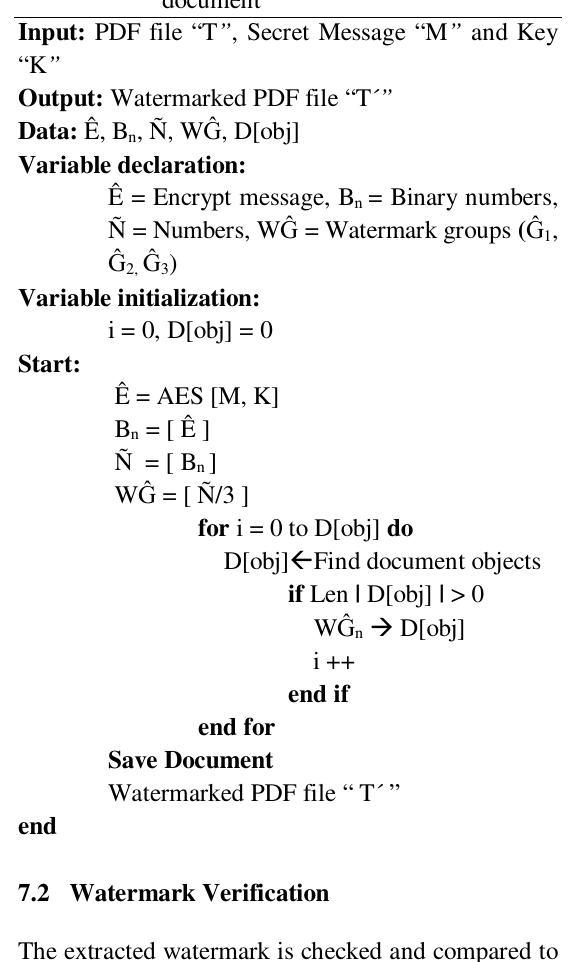
Algorithm 2: Watermark extraction from PDF